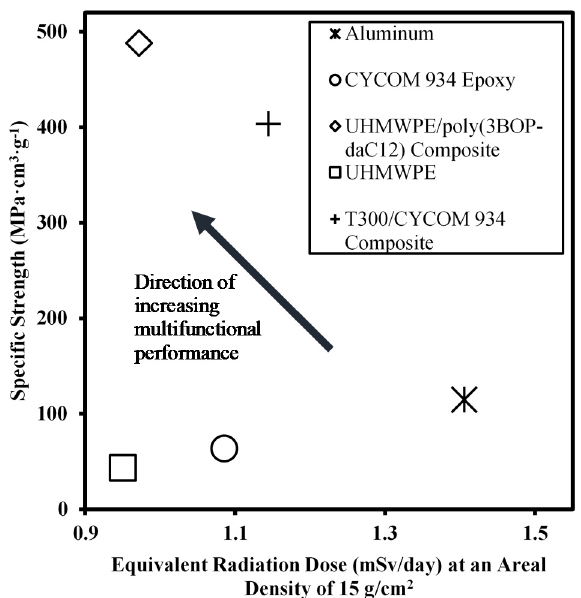
Figure 7. Plot of specific strength versus equivalent radiation dose for selected materials. Arrow indicates direction of increasing multifunctional performance in terms of higher specific strength and lower radiation dose.